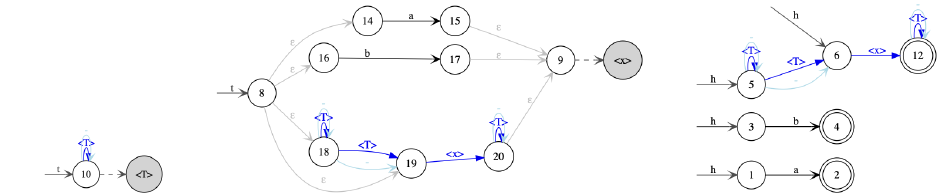
Figure 13. Stepwise hedge automaton step ( ch ∗ ( a + b )) : the part with the stepwise tree automaton is on the left and middle, and the N FA part on the